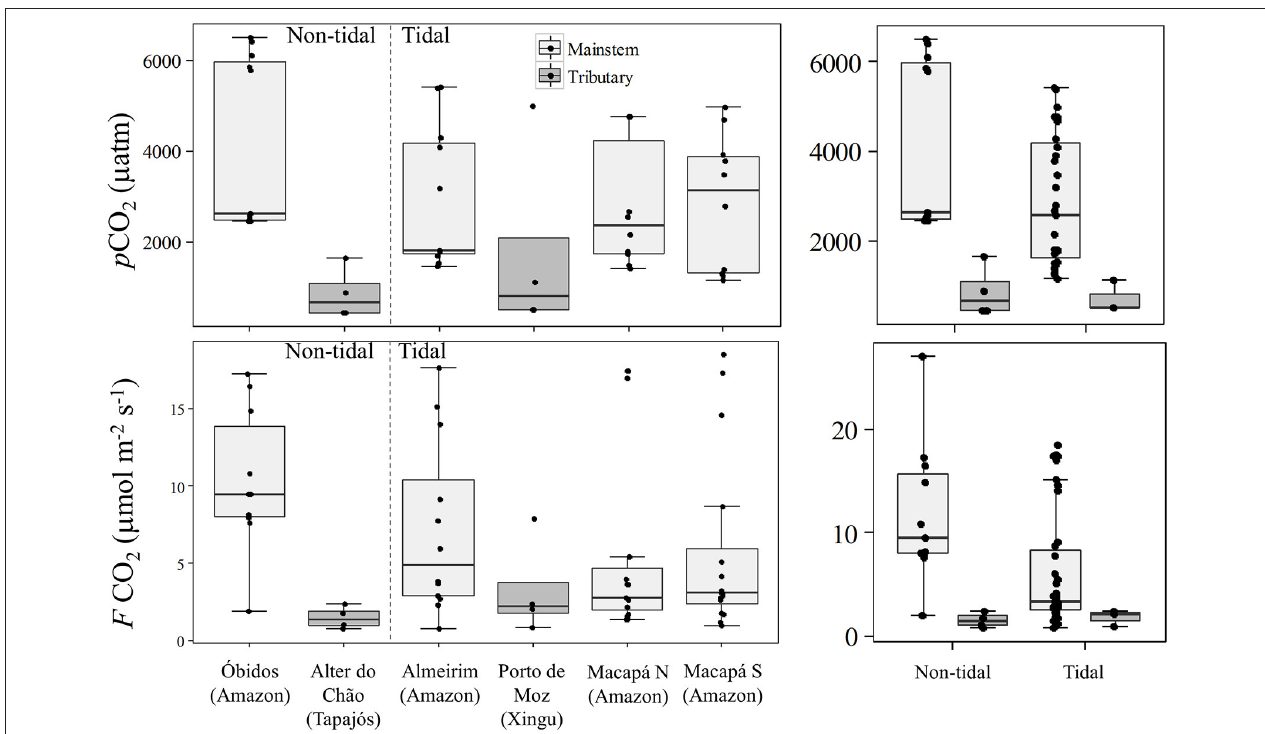
FIGURE 2 | Box plots showing the overall variability in p CO 2 and CO 2 flux to atmosphere in the Lower Amazon River mainstem and in two of the major Lower Amazon tributaries situated in the non-tidal or tidal river.